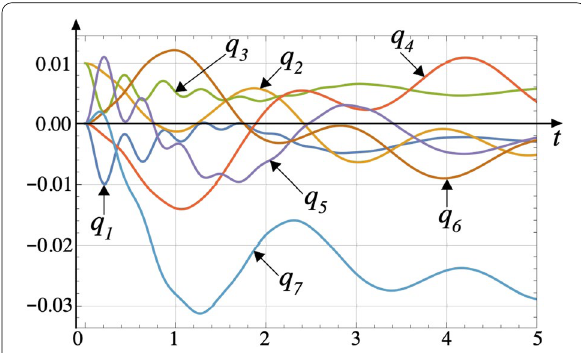
Fig. 5 Free vibration response obtained by using the general methodology, showing the characteristics of dynamic response of this system. Note that the initial conditions are